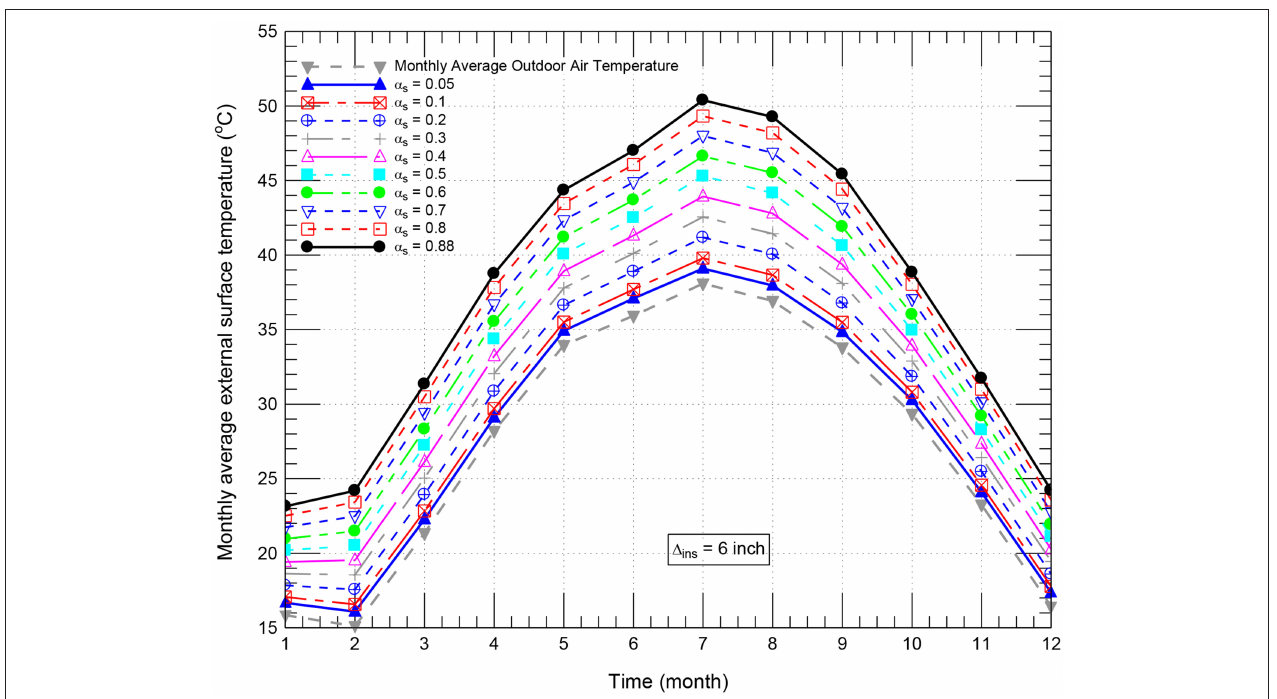
FIGURE 9 | Comparison of monthly average external surface temperature of conventional/black roof ( α s = 0.88) and cool roof of different short-wave solar absorption coefficients ( α s ) for 1 ins = 152mm (6.0